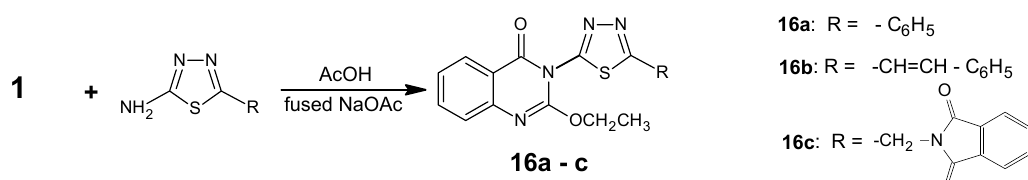
Scheme 21. Mass spectra interpretation for compounds 16a-c